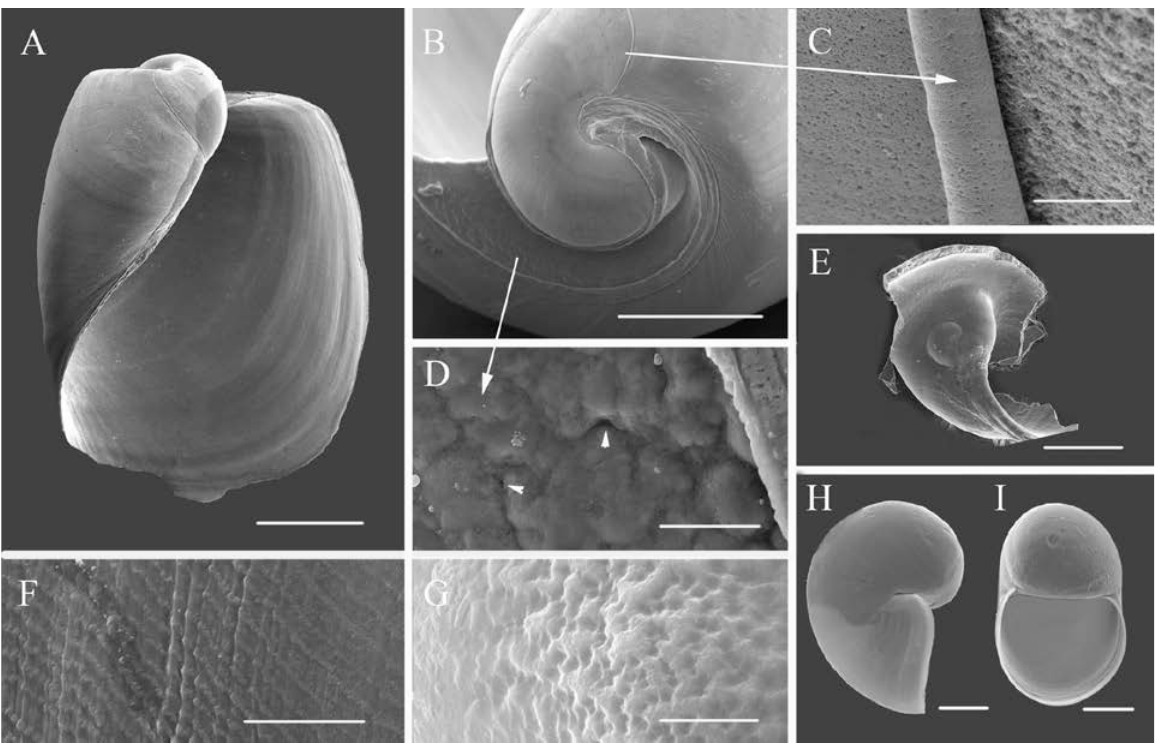
Figure 3. Philinissima denticulata collected in the Barents Sea, shell (SEM): ( A )—ventral view; ( B )—apical view; ( C )—protoconch border; ( D )—intercalated part of shell between protoconch and body whorl keel, pores marked by the short arrows; ( E )—protoconch inside of broken definitive whorl; ( F )—shell sculpture. Shell of newly hatched veliger: ( H )—lateral view, ( I )—ventral view, ( G )—sculpture of veliger. Scale bars: 5 μm ( G ), 10 μm ( C , D ), 30 μm ( F , H , I ), 200 μm ( B , E ), and 500 μm ( A ).